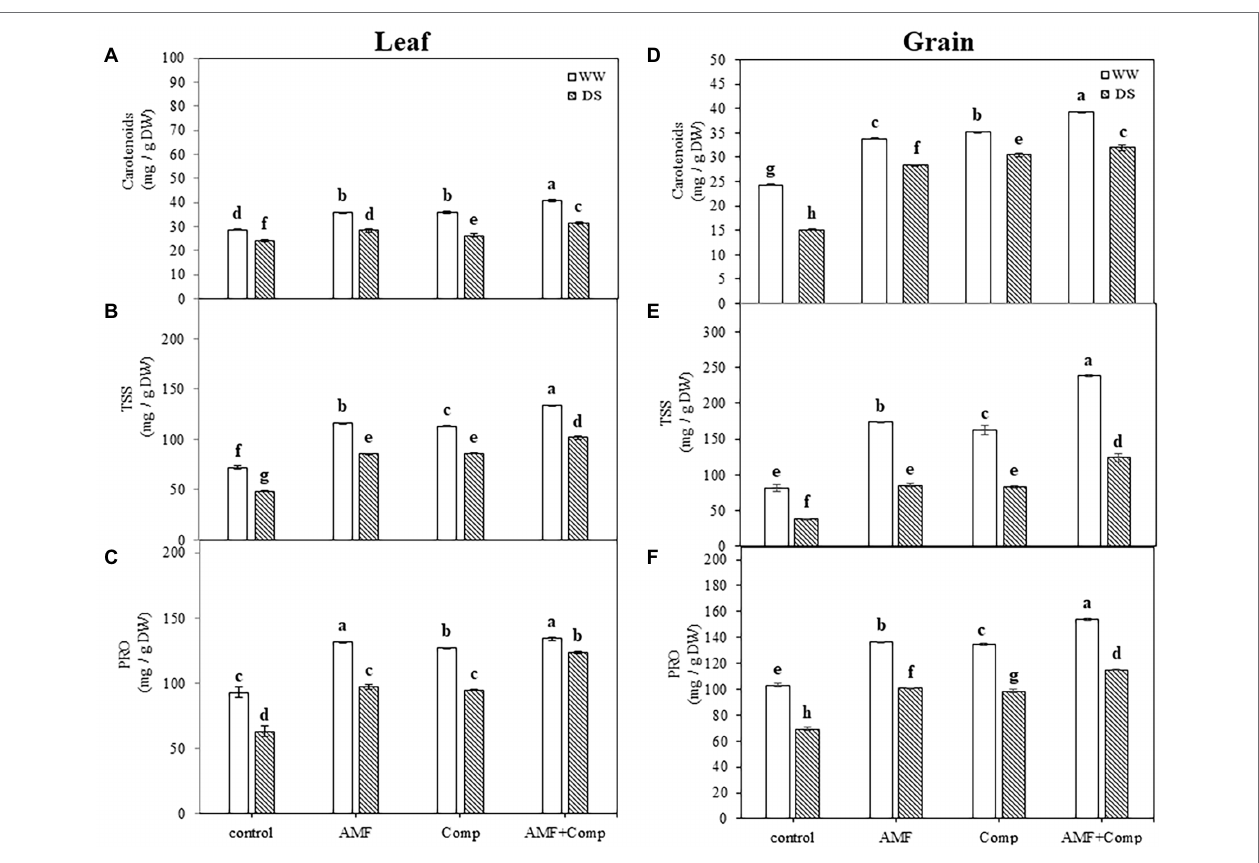
FIGURE 2 | Effects of water regimes (WW; well-watered or DS: drought stress) on leaves and seeds (A,D) carotenoids, (B,E) total soluble sugar content, and (C,F) protein content of non-amended and non-inoculated quinoa (control), and quinoa inoculated with arbuscular mycorrhizal fungi (AMF) and/or amended with compost (Comp). Data are mean ± SD. Means followed by the same letters are not significantly different at p <